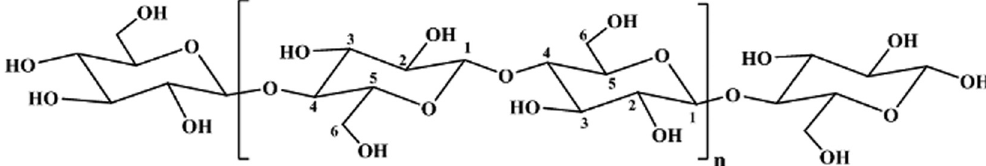
Figure 2: Molecular structure of cellulose